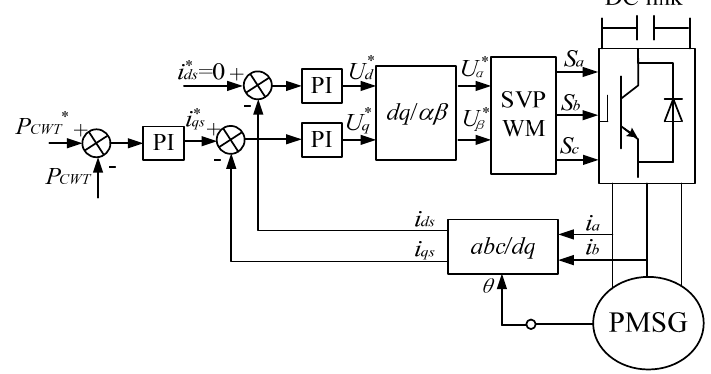
Figure 7. Control diagram of the control wind turbines.